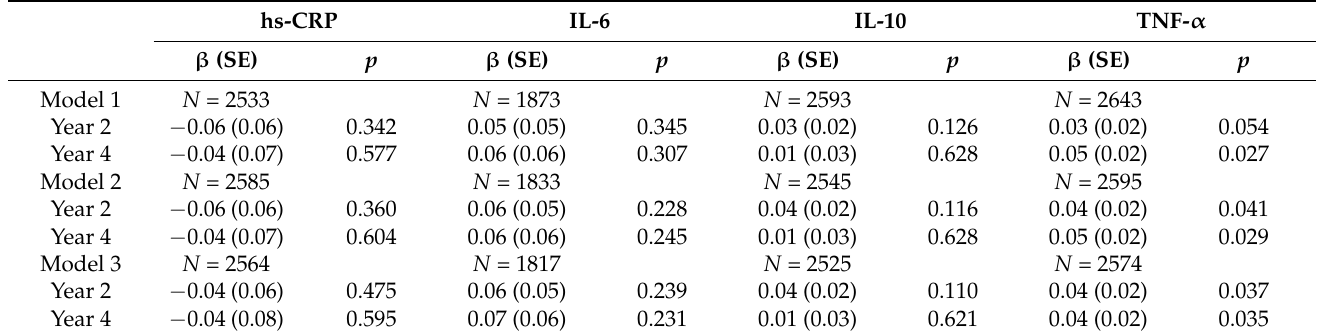
Table 5. Compliance-adjusted analysis of marine n -3 fatty acids on log-transformed inflamma- tory